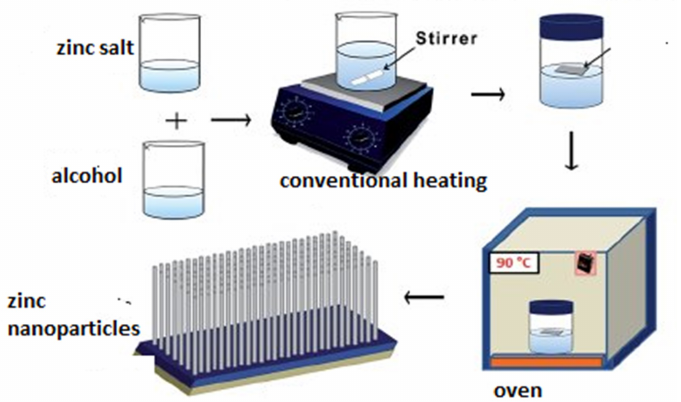
Figure 4. Overview of the hydrothermal method to synthesize ZnO nanoparticles. Reproduced with permission from